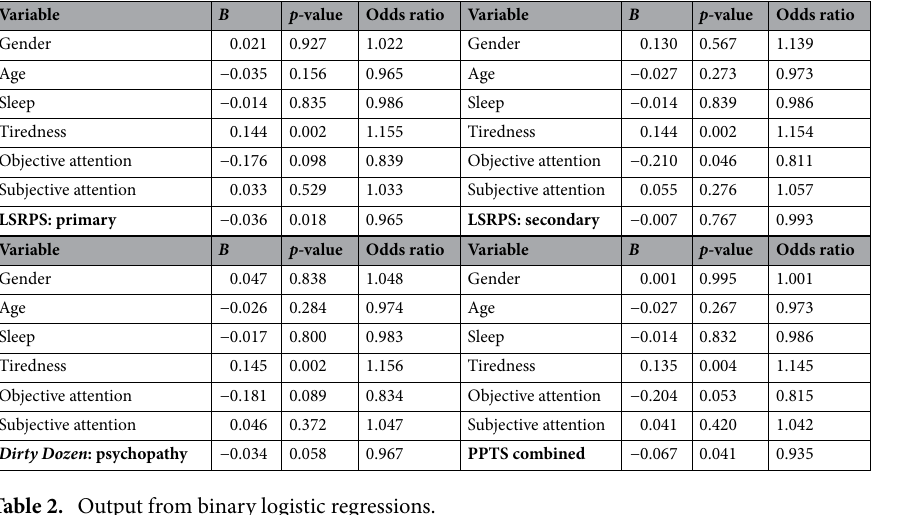
Table 2. Output from binary logistic